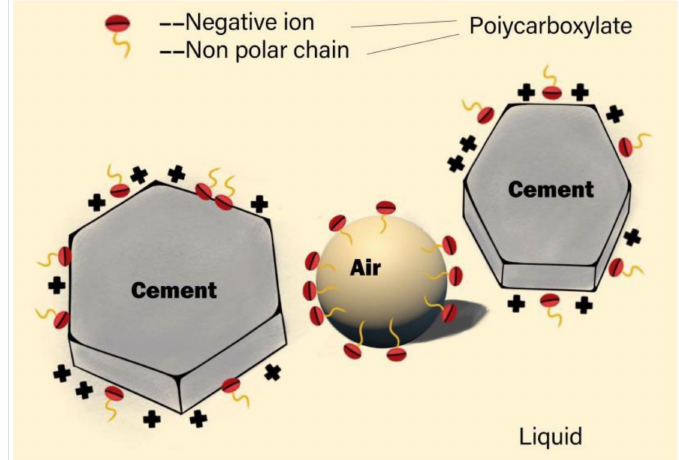
Figure 1. The mechanism of action of PCE.